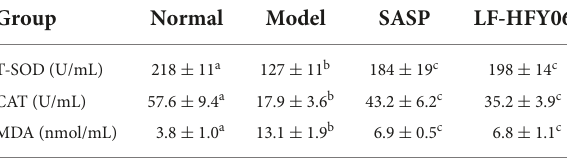
TABLE 4 Serum levels of T-SOD, CAT, and MDA in mice of each group. Group Normal Model SASP LF-HFY06